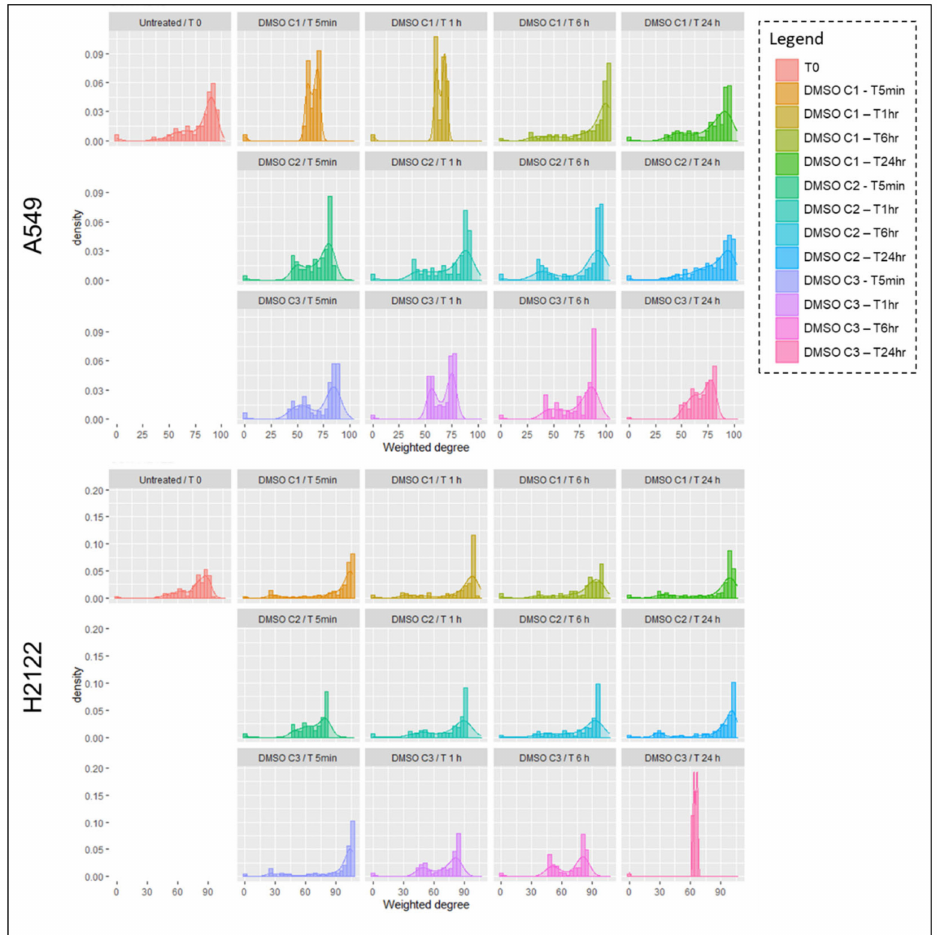
Figure 2. Histograms and kernel density plots representing weighted Pearson’s correlation coeffi- cients for each DMSO dose across timepoints for A549 and H2122. Weighted Pearson’s correlation coefficients were calculated for paired proteins across all measured analytes and the degree of distribution of pair-wise interconnections between analytes is shown for each cell lines, DMSO concentration, and